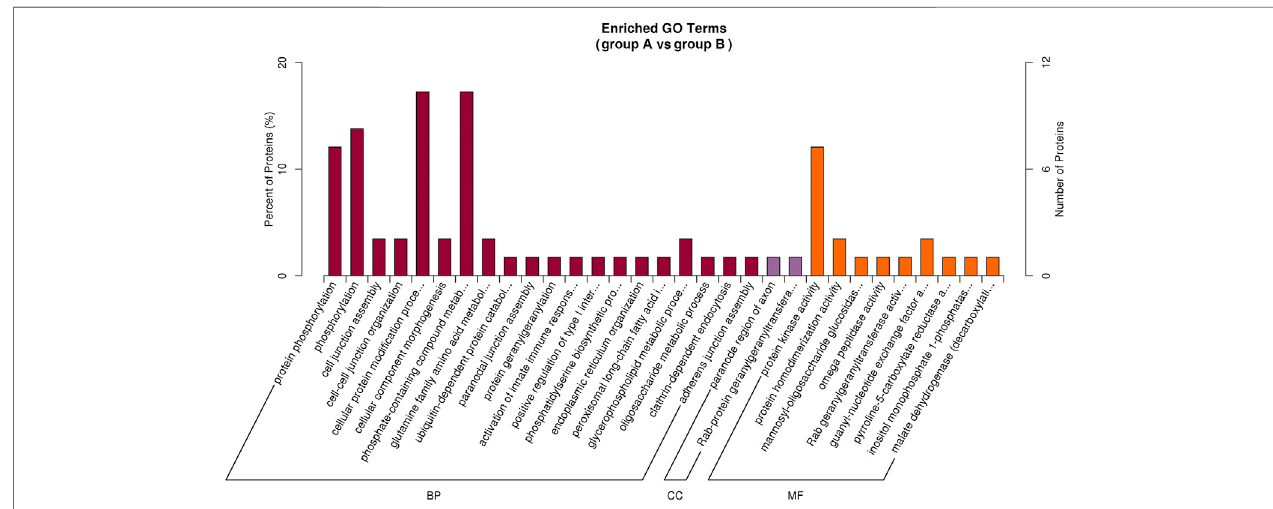
FIGURE 5 | Illustration of the top 20 G.O. enrichment terms of all DEP. There are three categories of G..O. enrichment terms, biological process (B.P.), molecular function(M.F.),andcellularcomponent(CC).ThemostDEPenrichedinbiologicalprocess(darkred),andonlytwoCCtermshadDEPenriched(purple).Therewerenine terms of MF (orange) were enriched by